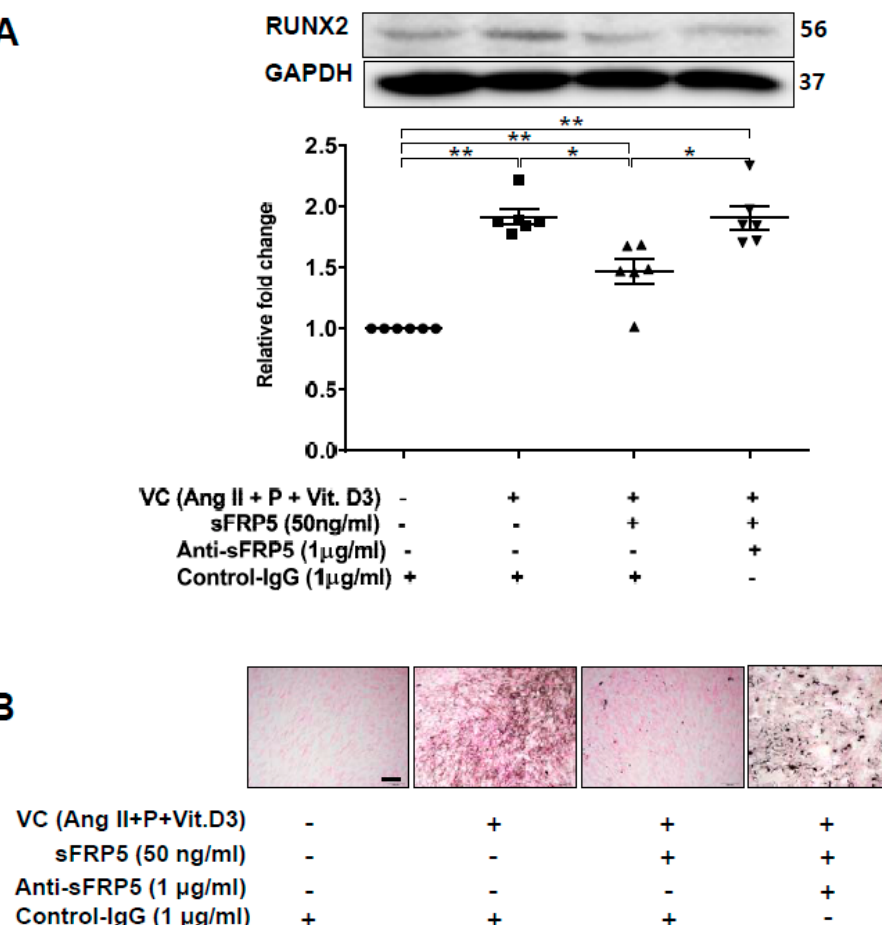
Figure 3. Secreted frizzled-related protein 5 ( sFRP5) inhibited osteoblastic trans-differentiation of vascular smooth muscle cells (VSMCs) cultured in vascular calcification (VC) induction media (high-phosphate, angiotensin II, and vitamin (D). The protein level of RUNX2 was determined using Western blotting, and calcification was confirmed visually by von Kossa staining. Six replicates per condition were performed. ( A ) Treatment with sFRP5 of VSMCs in VC induction medium decreased the expression of RUNX2, and neutralization with anti-sFRP5 restored the expression of RUNX2 to control immunoglobulin G levels; ( B ) VSMCs cultured in VC induction medium with different additional interventions and stained with von Kossa stain are shown. Six replicates per condition were performed. VSMCs incubated in VC induction medium showed significantly increased staining compared with the control. Treatment with sFRP5 led to the attenuation of staining, and the addition of anti-sFRP5 resulted in increased staining. Scale bar, 100 µm. Data are expressed as means ± standard errors of the means from six independent experiments. * p < 0.05, ** p < 0.01.